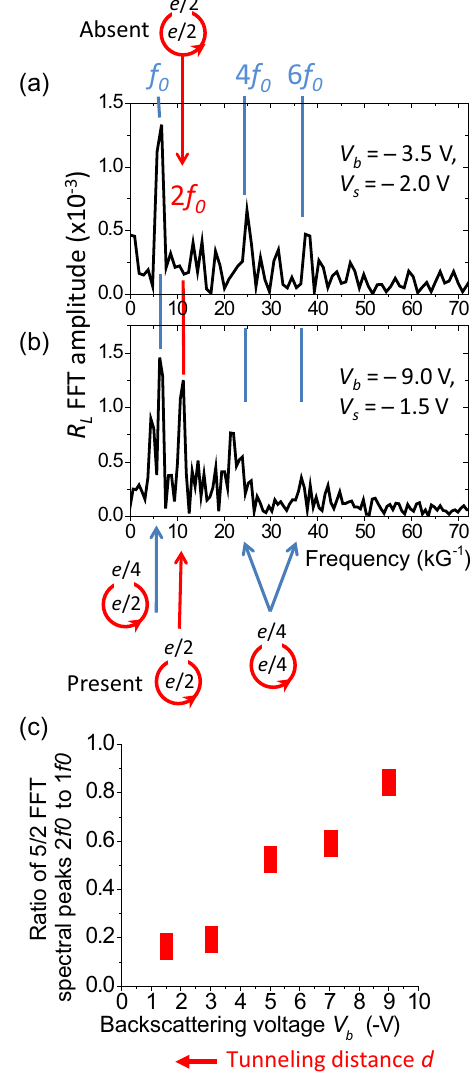
FIG. 14. (a),(b) ν ¼ 5 = 2 oscillation spectra at two different gate-voltage settings (sample 2, preparations 1 and 2, device type b, T ∼ 20 mK). The spectrum in panel (b) shows four peaks at f 0 , 2 f 0 , 4 f 0 , and 6 f 0 , consistent with e= 4 and e= 2 interference. The 2 f 0 peak is absent when the backscattering gate voltage V is b changed from − 9 to − 3 . 5 V, increasing the tunneling distance d for interfering quasiparticles. The side-gate voltage V is adjusted s to preserve the area A . (Supplemental Material Sec. S5h, Fig. S5-25 [34] demonstrate the overall similar transport between ν ¼ 2 and 3 for these gate settings.) (c) Ratio of the peak value at 2 f 0 to that at f 0 for a series of backscattering gate voltages V b in the same device (sample 2, preparations 1 to 5, T ∼ 20 mK). The increase of the peak amplitude ratio in response to the con- striction narrowing (more negative V ) may be reflecting relative b tunneling amplitudes for e= 2 and e= 4